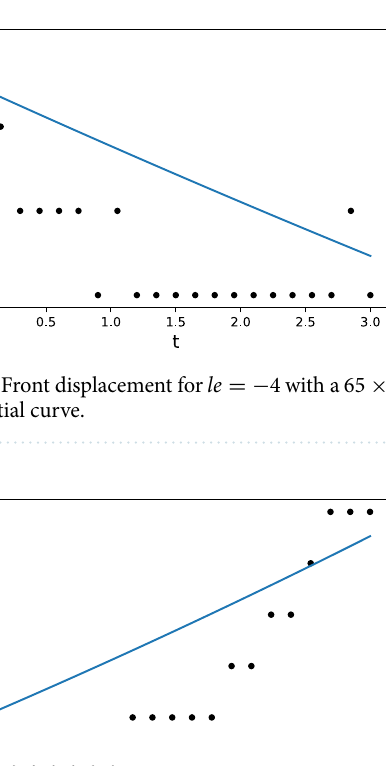
Figure 15. The same as Fig. 14 but for le